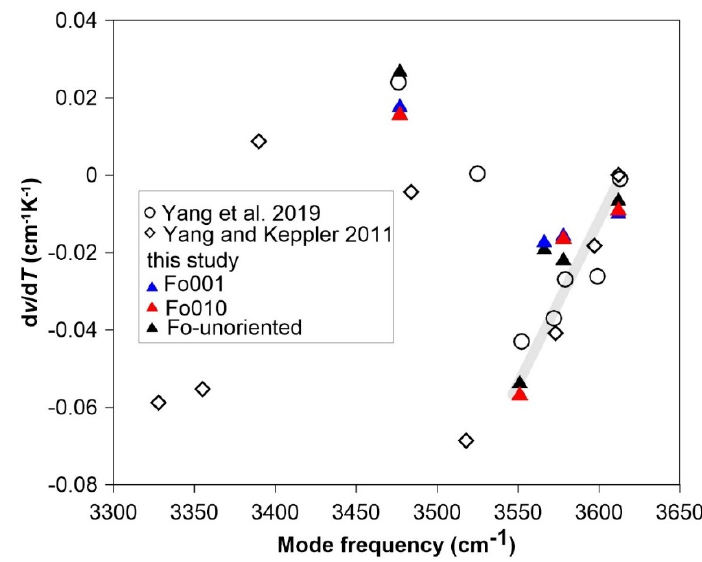
Figure 8. Comparison of the temperature-dependence for the frequencies of OH bands of hydrous olivine ([34,41]; this study).